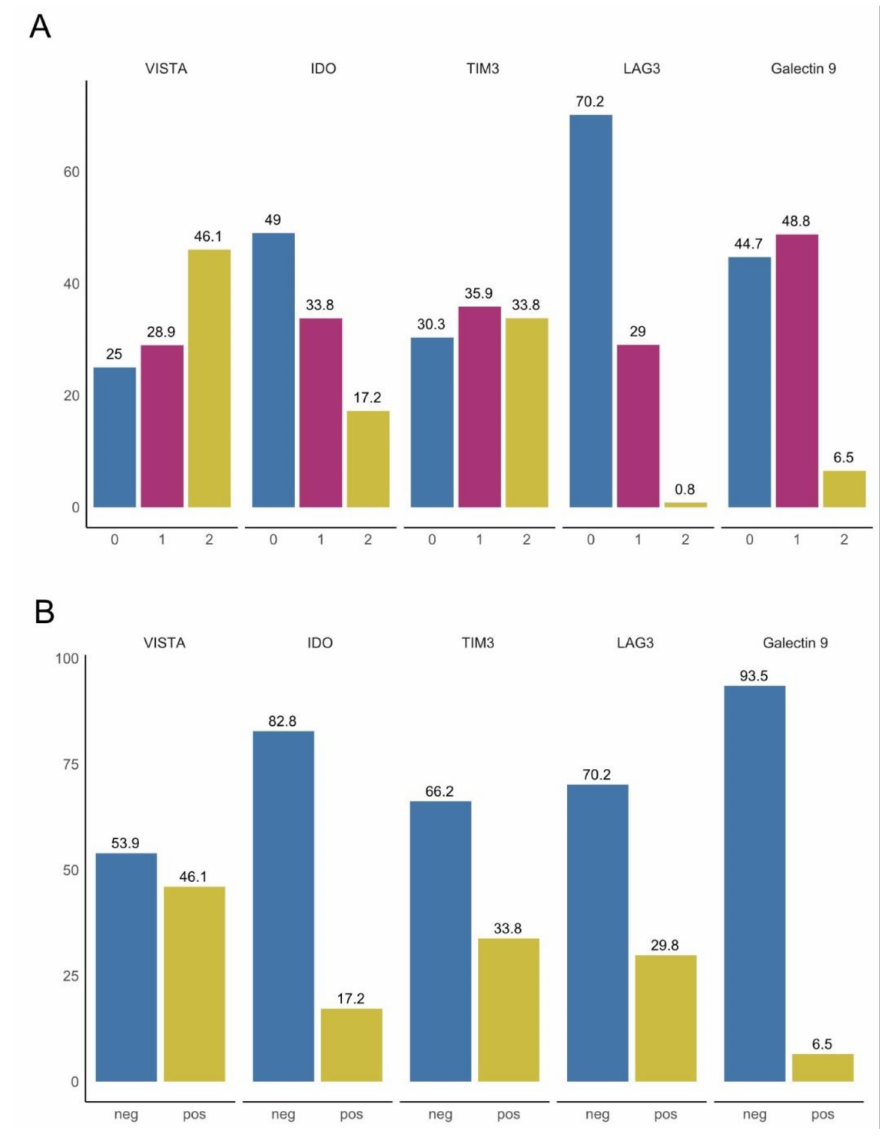
Figure 2. Expression of checkpoint molecules in the pancreatic cancer cohort. ( A ) For VISTA, 38 (25.0%) tumors were negative (0), while low (1) and high (2) expression was detected in 44 (28.9%) and 70 (46.1%) tumors. IDO was negative in 74 (49%) tumors, low and high expression was detected in respectively 51 (33.8%) and 26 (17.2%) tumors. TIM3 was negative in 43 (30.1%) tumors, low and high expression was detected in respectively 52 (36.4%) and 48 (33.6%) tumors. LAG3 was negative in 86 (69.9%) tumors, low and high expression was detected in respectively 36 (29.3%) and 1 (0.8%) tumor. ( B ) Negative and low-expressing tumors were combined into one group (neg) and compared with high-expressing tumors (pos) for the analysis of VISTA, IDO, and TIM3. Because there was only one LAG3-positive-expressing tumor, we combined the positive tumor with the low-expressing tumors into the positive group (pos) for LAG3